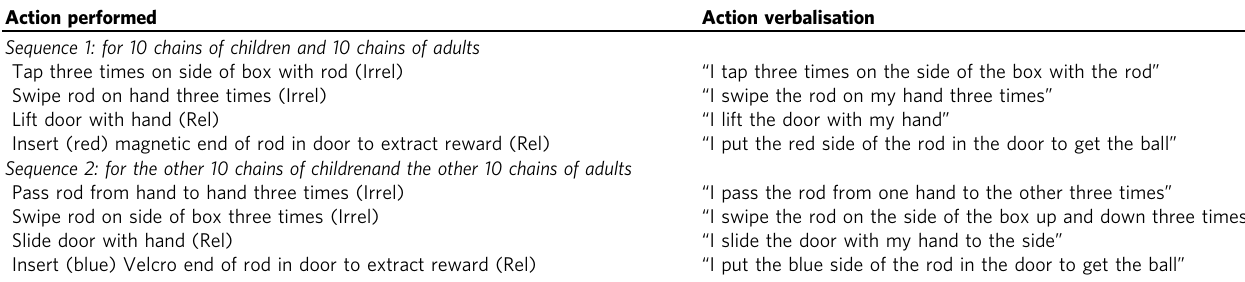
Table 1 Action sequences performed (in the demonstration condition) or verbalised (in the verbal instruction condition) by the seeds (Generation 0).